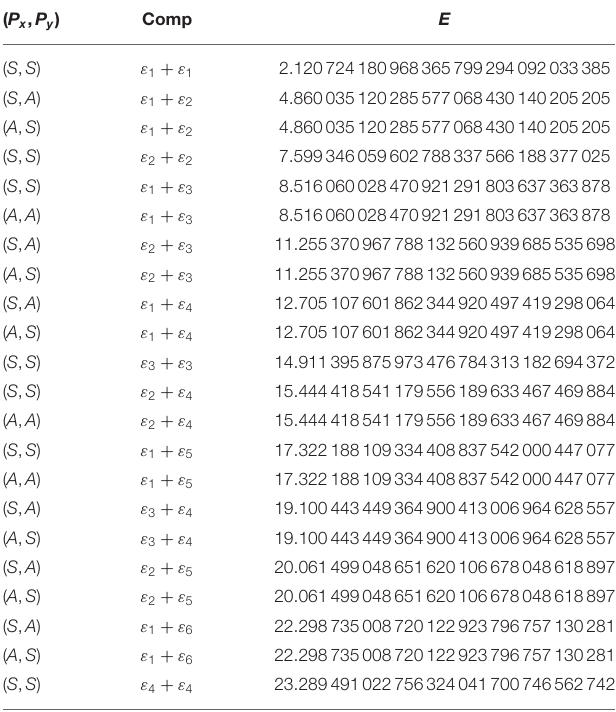
TABLE 3 | The 22 lowest eigenvalues E of the two-dimensional quantum anharmonic oscillator, as defined by the Schrödinger